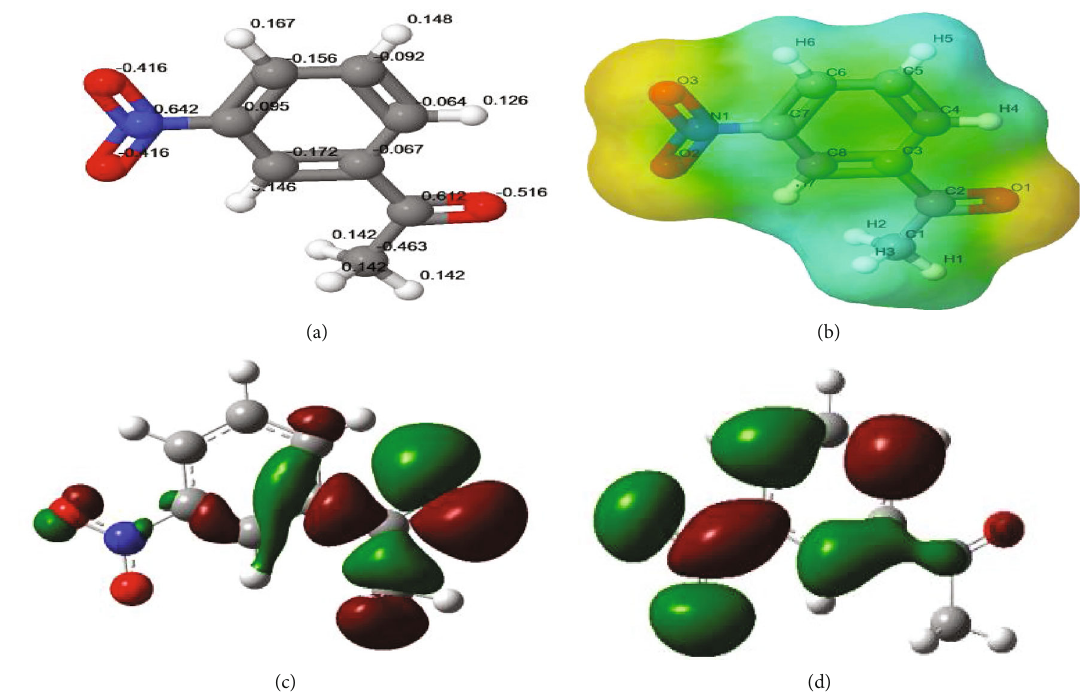
Figure 10: (a) Optimized structure, (b) electrostatic potential, (c) HOMO, and (d) LUMO of